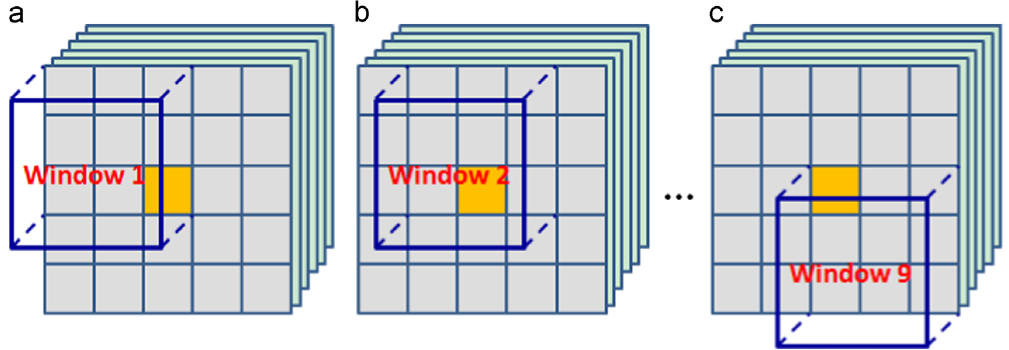
Figure 1. Multiple local window filters [13] ( a ) Window 1. ( b ) Window 2 and ( c ) Window